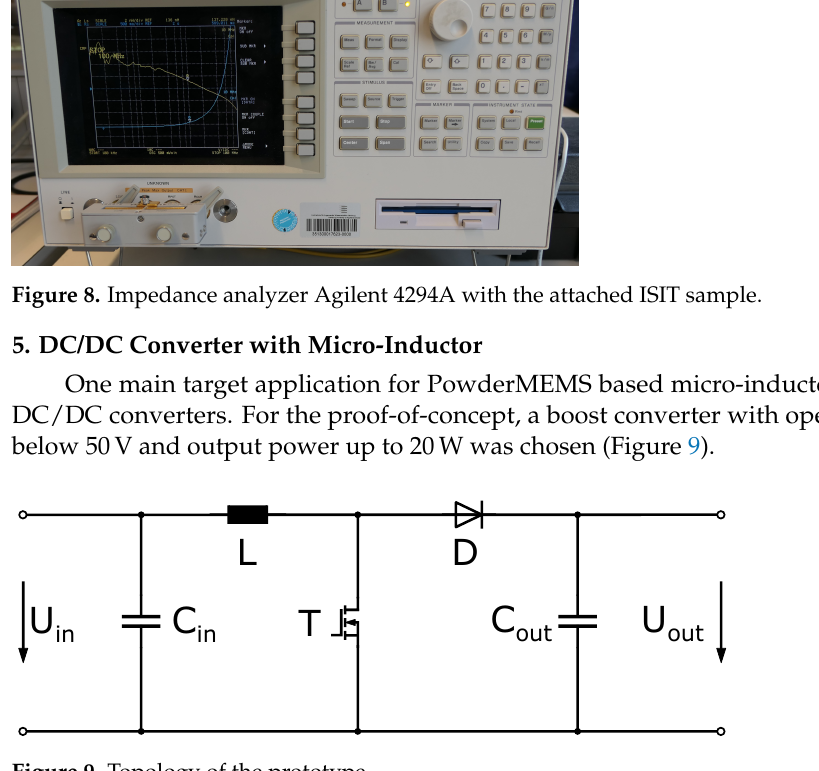
Figure 9. Topology of the